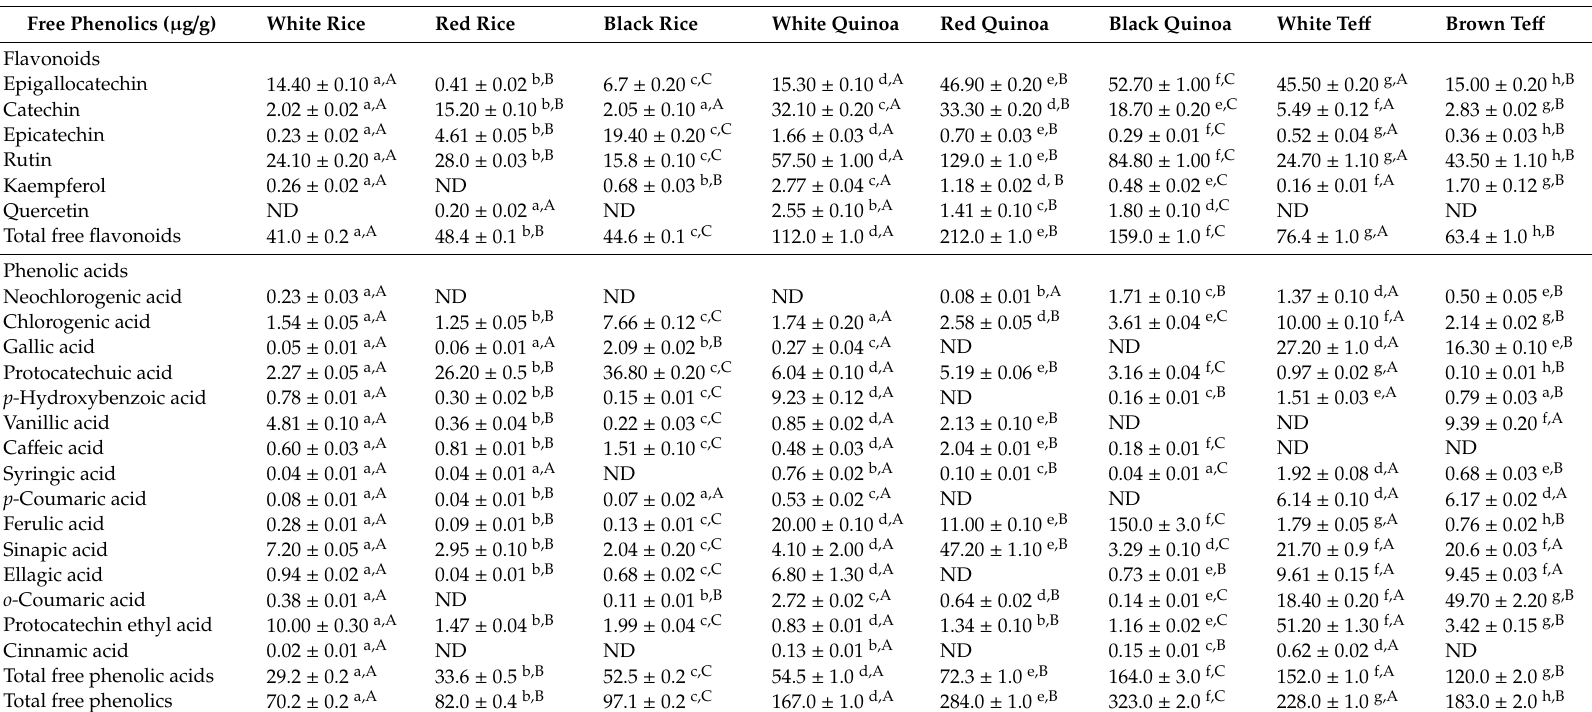
Table 4. Results of individual phenolic concentrations in free phenolic fractions of non-traditional